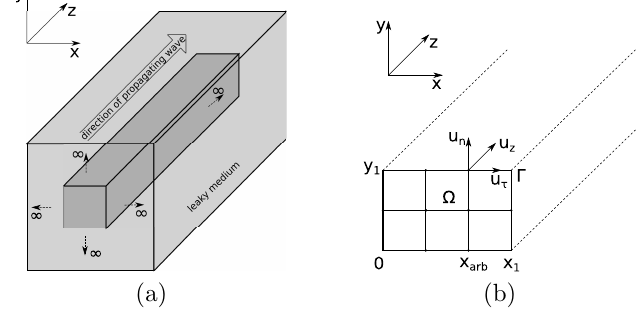
Figure 1. (a) Scheme of immersed waveguide; (b) Discretization of cross-section of the